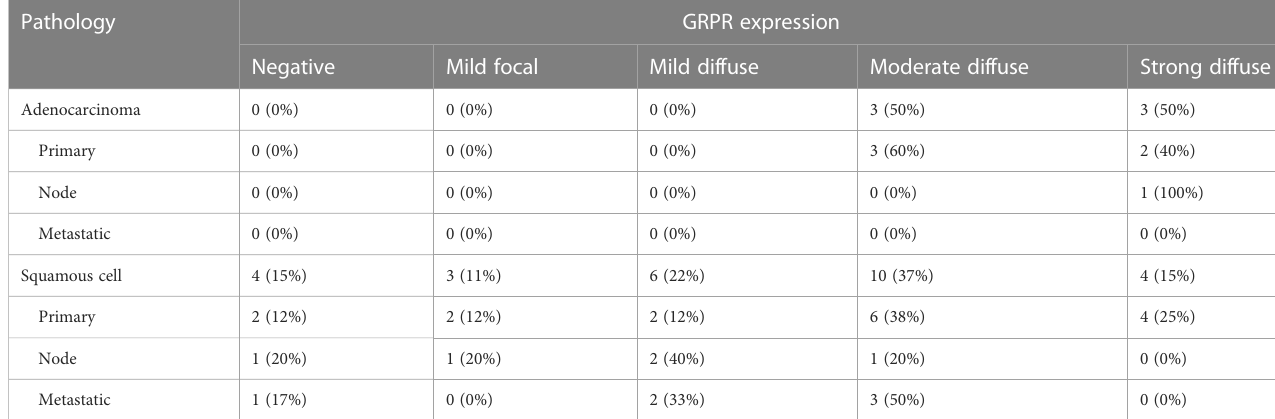
TABLE 2 GRPR incidence, distribution, and intensity in uterine cervix cancer